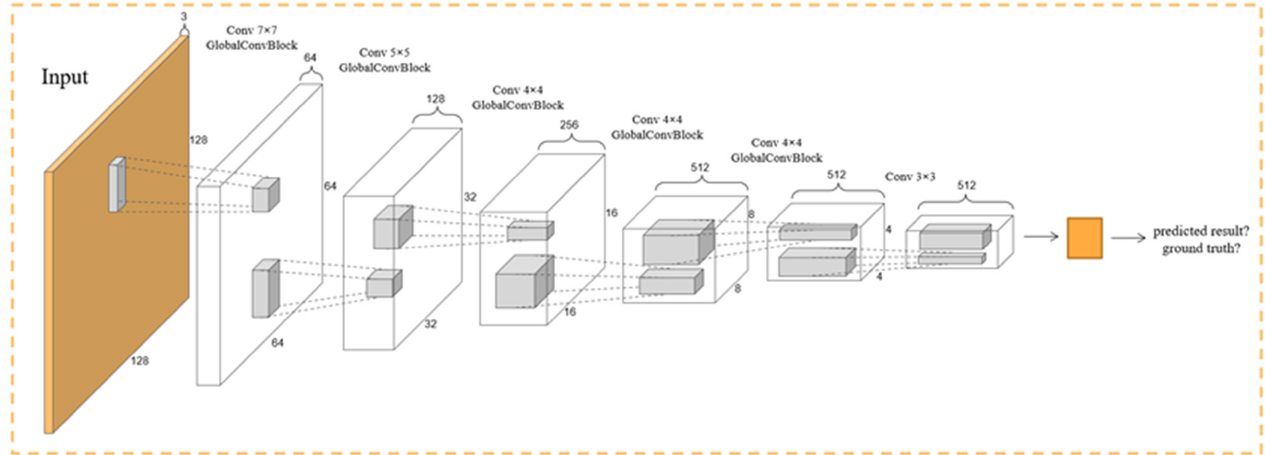
Figure 6. Structure of discriminator Network.